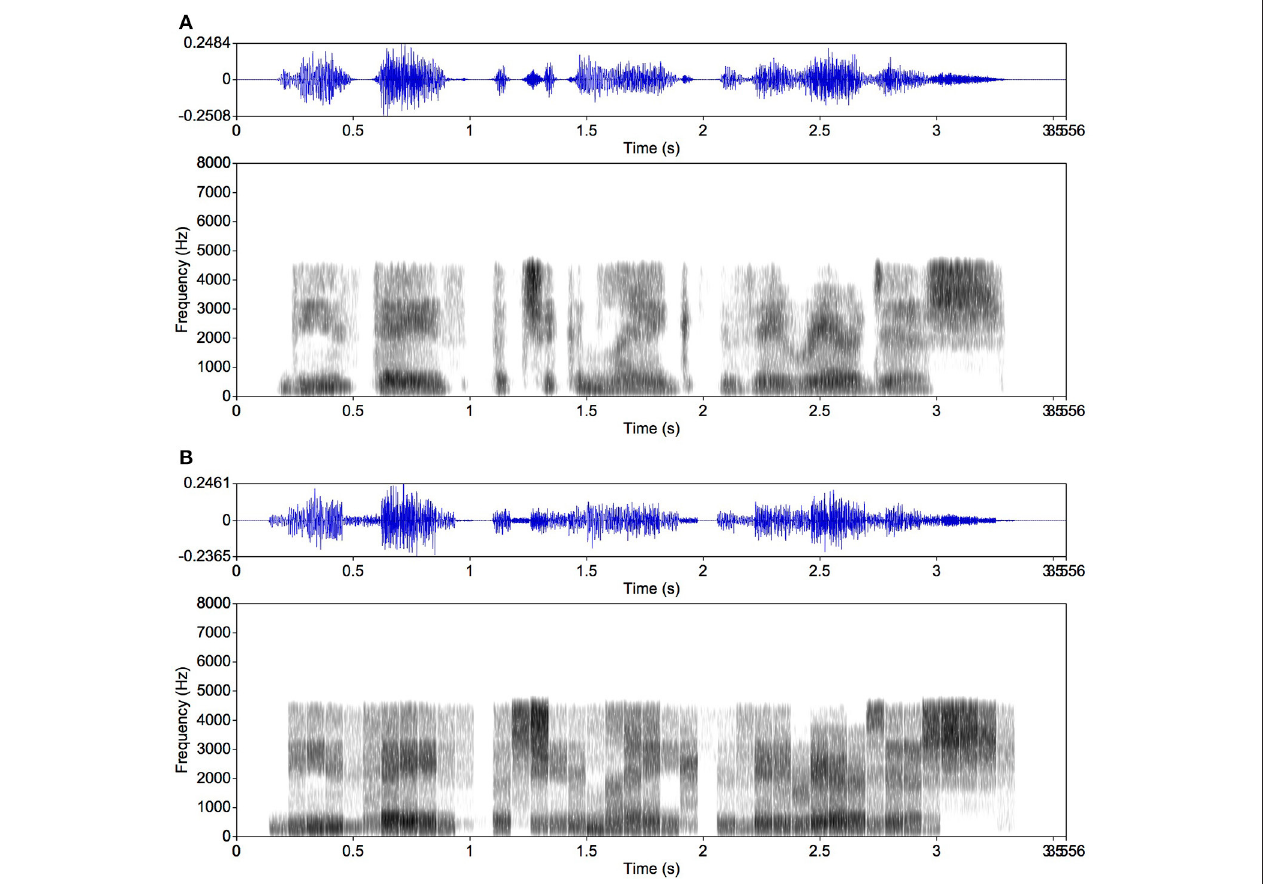
FIGURE 3 | Examples of noise-vocoded speech (Shannon et al., 1995; Smith et al., 2002; Ellermeier et al., 2015; Kishida et al., 2016) and mosaic speech. The same original speech as in Figure 2 was used. (A) Noise-vocoded speech made of amplitude-modulated noises in 17 critical bands; (B) mosaic speech: the noise-vocoded speech mosaicized into 80-ms segments. Intuitively, the mosaic speech was constructed by cutting the original speech as appeared in the spectrogram into time-by-frequency blocks of 80 ms and one critical bandwidth, and by leveling the sound-energy density in each block. Because the uncertainty principle between time and frequency does not allow the spectrum of a noise portion to be kept within a narrow frequency band if the portion appears and disappears abruptly, each block was shaped with a rise time and a fall time of 5 ms.